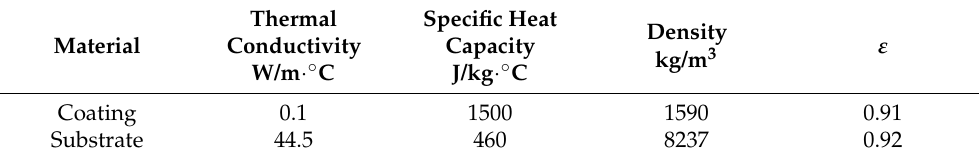
Table 7. Thermophysical properties of the coating and